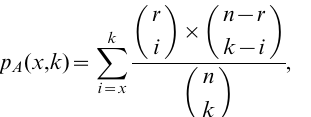
Figure S1 Fully scalable version of the ligand-target malaria network of 1,908 phenotypically active compounds (white circles)